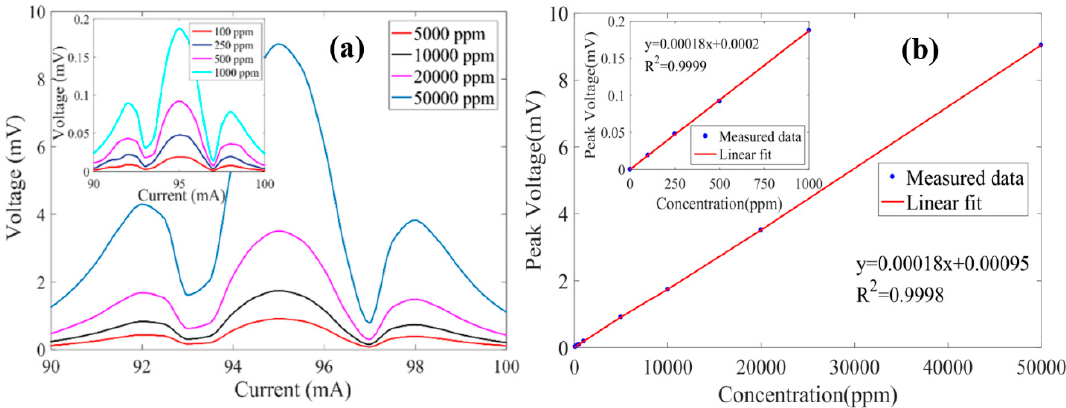
Figure 6. ( a ) Measured 2 f -WMS signals with different concentrations of CH 4 . ( b ) Relationship between peak value and gas concentration.